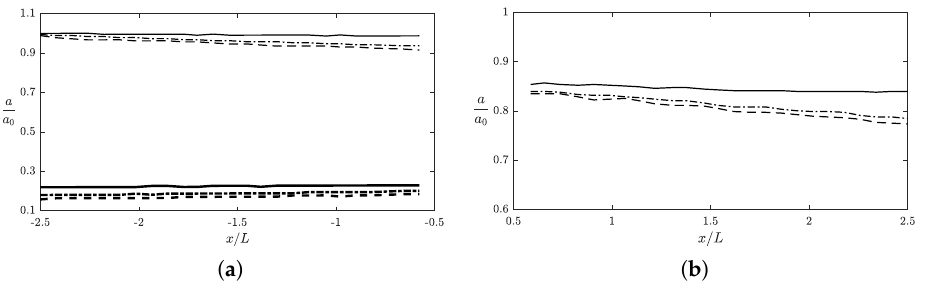
Figure 13. Spatial variation of amplitude ratio, a / a 0 , due to a bottom obstacle above a muddy bed with different thicknesses. Solid lines: d m = 0 (solid bottom). Dashed lines: d m = δ m . Dashed-dotted lines: d m = 3 δ m . Vertical bars indicate the location of the bottom obstacle. In this case, T = 1.79 s, a 0 = 0.02 m, d = 0.8 m, ν m = 0.003 m 2 /s, ρ m = 1111 kg/m 3 , L o = 1.6 m, and D o = 0.4 m. See Figure 1b for the problem definition.